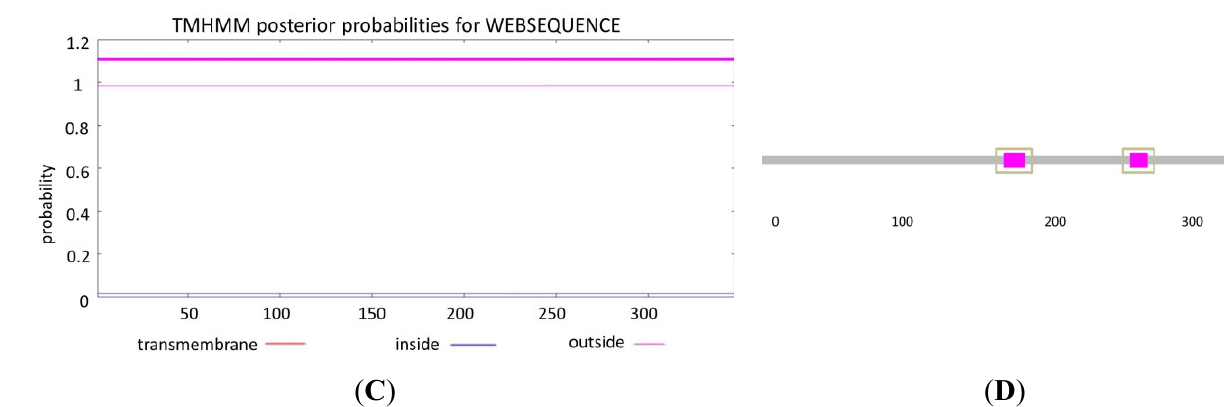
Figure 1. Bioinformatic analysis of GZDYun-P9-1. ( A ) Hydrophilic regions shown within the box; ( B ) signal peptide analysis; ( C ) transmembrane structures in P9-1 protein